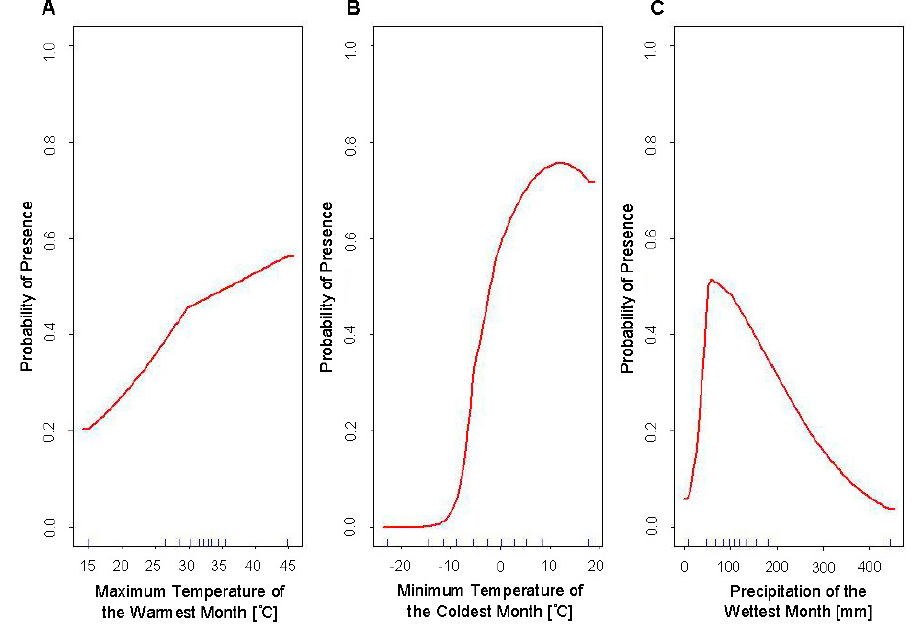
Figure 2. Response curves of the variables used in the final SDMs of Ae. aegypti (Model 1a) using all occurrence records showing predicted habitat suitability to ( A ) the maximum temperature of the warmest month (Bio5), ( B ) the minimum temperature of the coldest month (Bio6), and ( C ) the precipitation of the wettest month (Bio13).